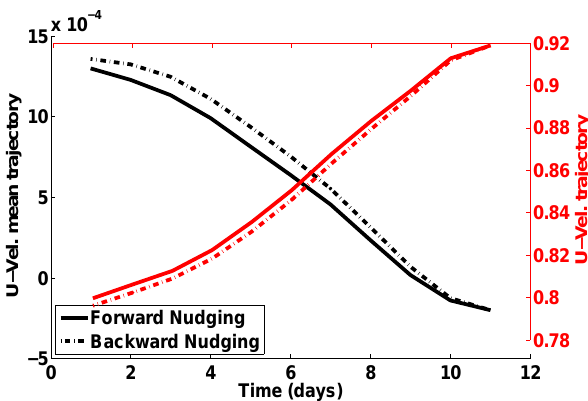
Figure 6. Forward and backward evolution of the spatially aver- aged (black curves) and single grid point (at 34 ◦ N and 52 . 6 ◦ W, red curves) surface zonal velocity during the last DBFN iteration. The corresponding grid point is located in the region of the unstable jet. Units on the vertical axes are expressed in ms − 1